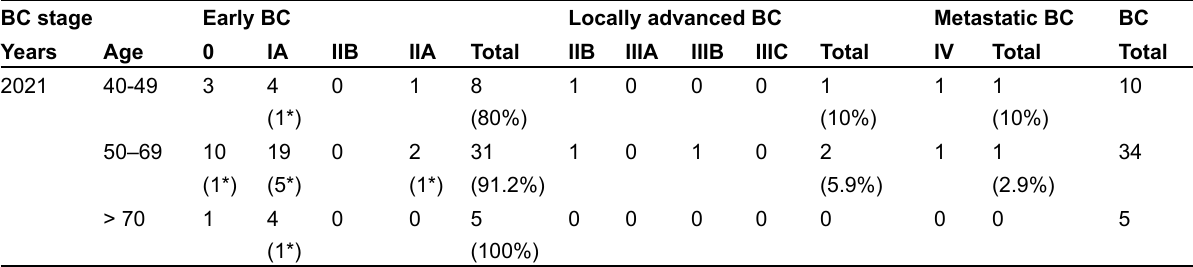
Table 4. BC staging in the years 2019, 2020, and 2021 ( continued ) BC stage